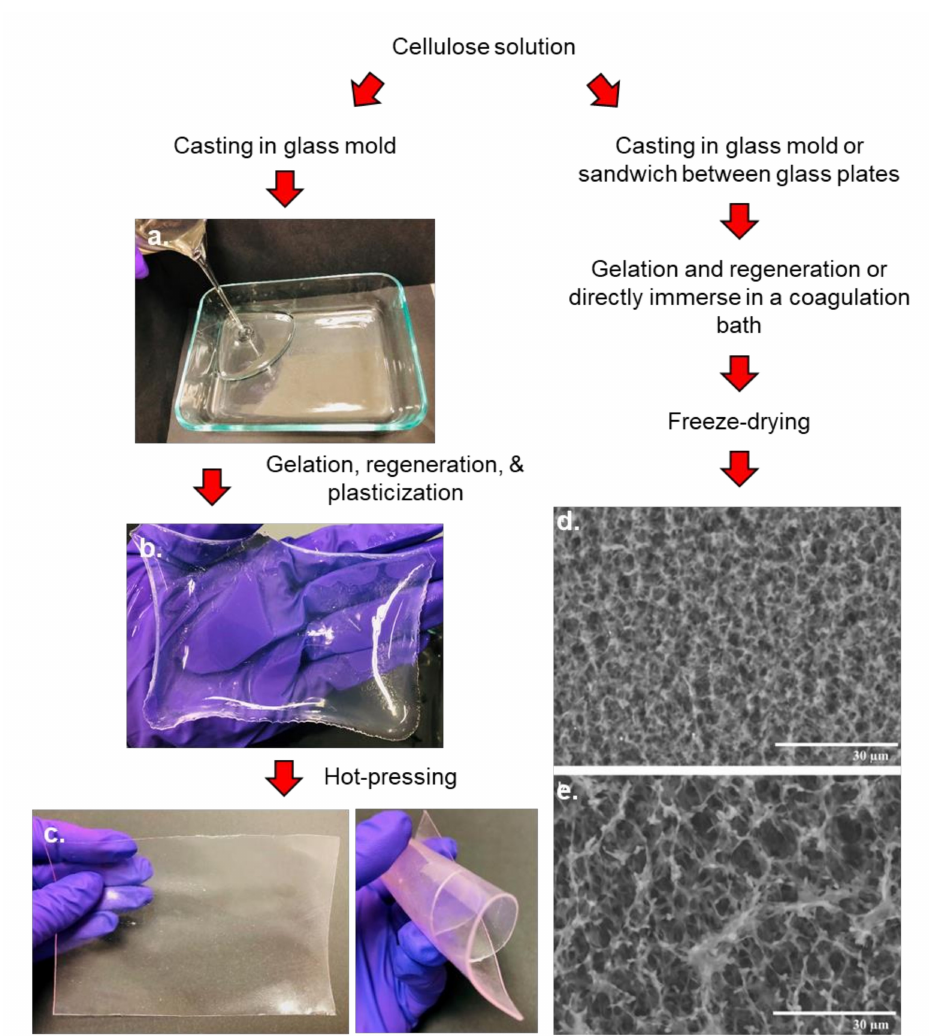
Figure 7. Production of non-porous and porous cellulose films via casting approach. ( a ) Casting cellulose solution in a glass mold, ( b ) regenerated and plasticized cellulose hydrogel, ( c ) hot-pressed flexible cellulose films, and porous cellulose films ( d ) free surface and ( e ) fracture surface (Figure 7d,e were reprinted from Ref. [16] with permission from